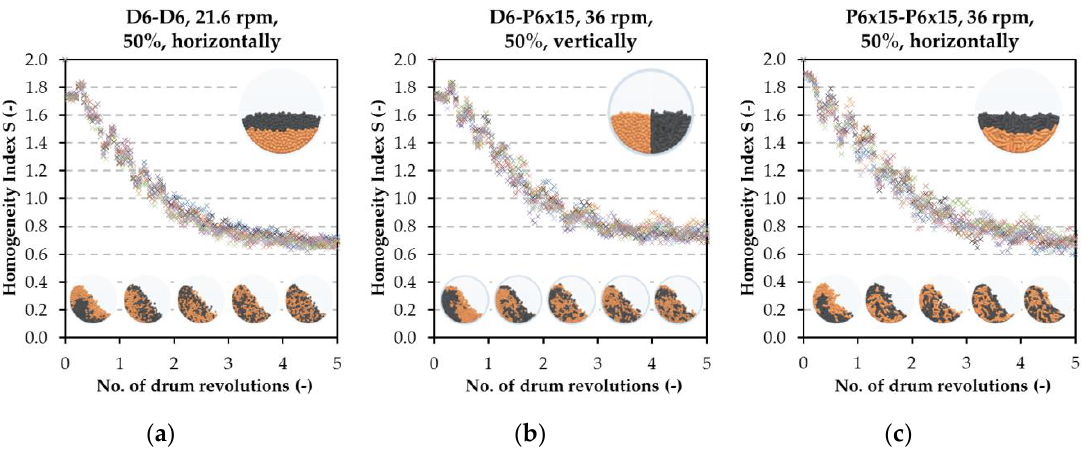
Figure 7. Reproducibility of the simulation results: ( a ) D6-D6, 21.6 rpm 50%, horizontally; ( b ) D6-P6 × 15, 36 rpm, 50%, vertically; ( c ) P6 × 15-P6 × 15, 36 rpm, 50%,